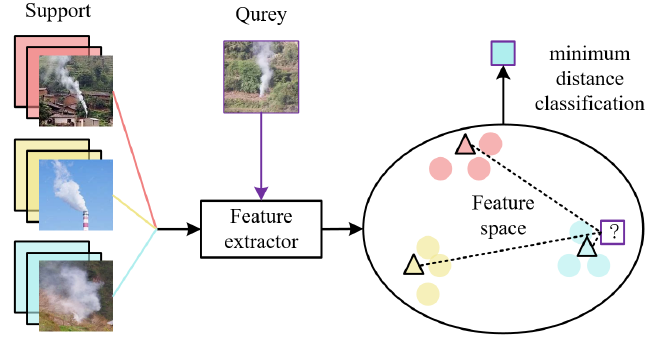
Figure 7. Model framework for smoke fine-grained identification task.